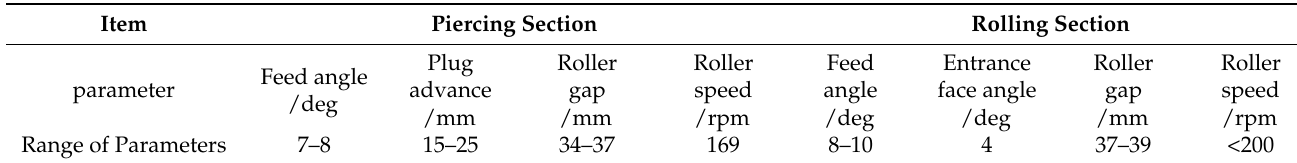
Table 1. Range of parameters in the TSR process.